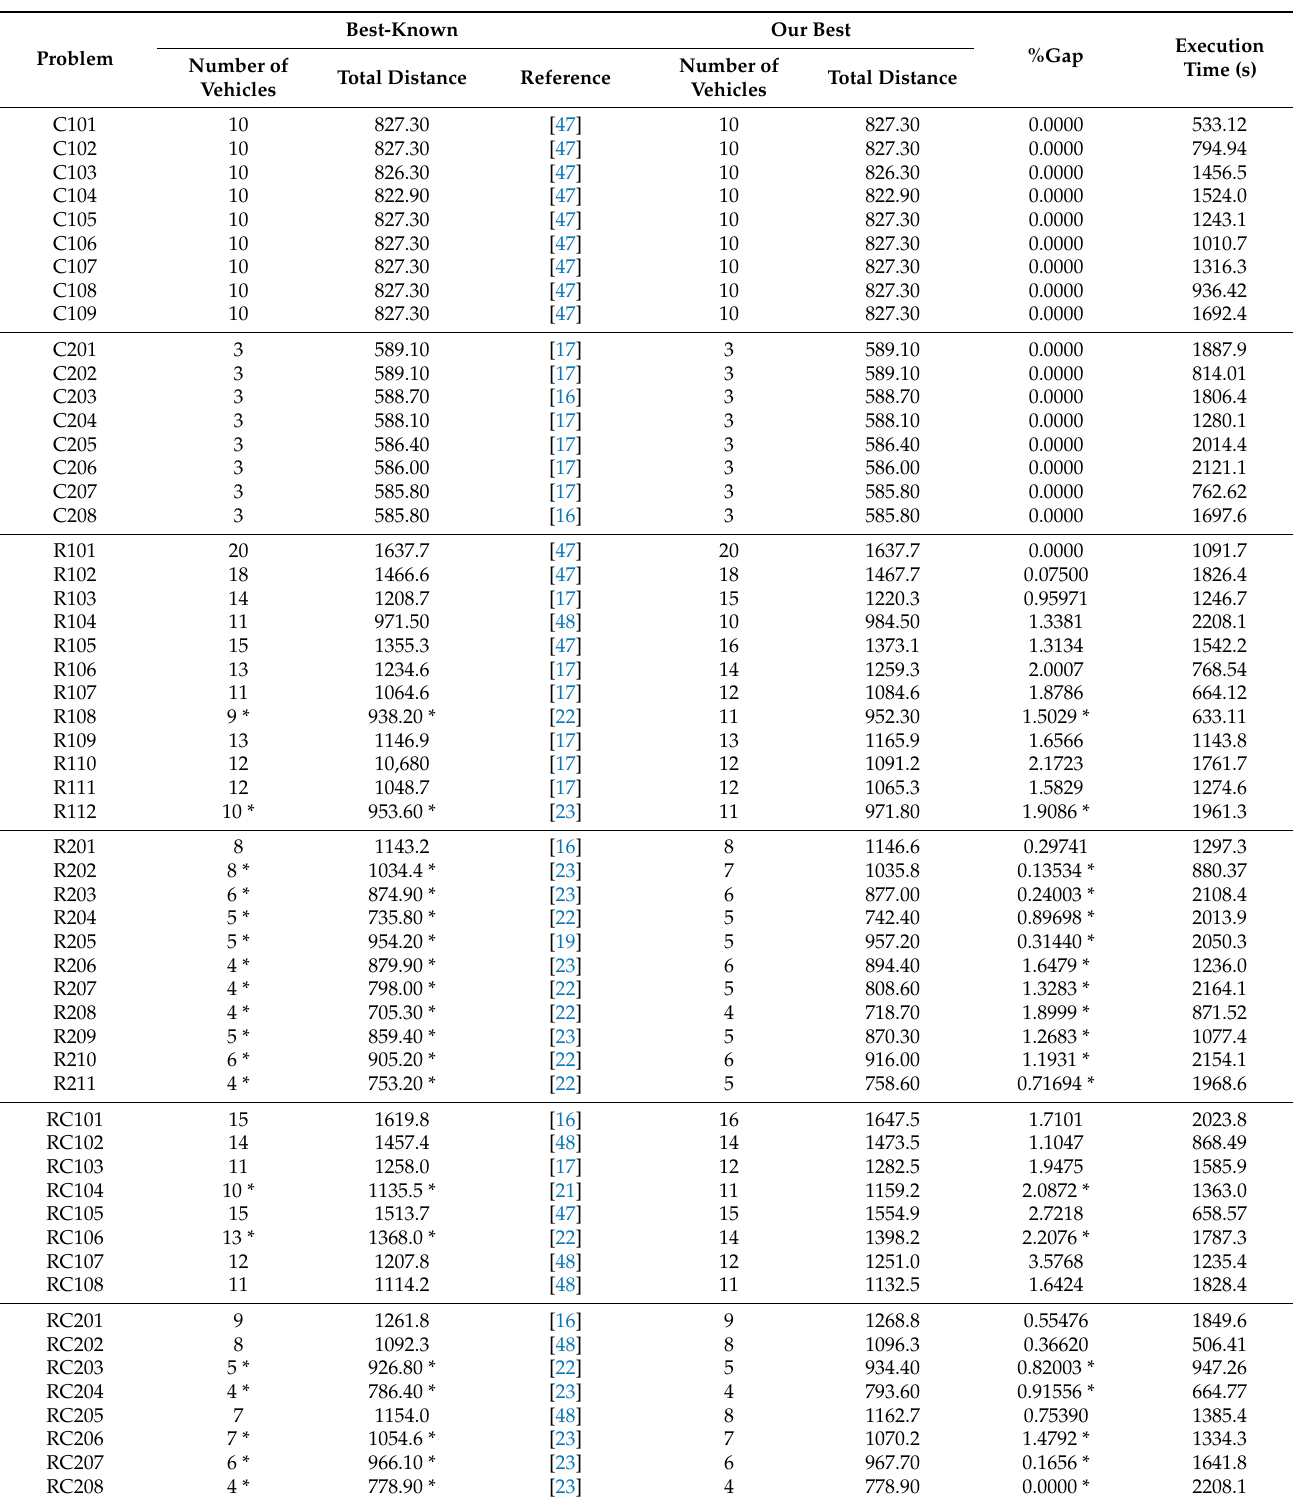
Table 5. Comparisons between the exact solution or best solutions (with “*”) and the results obtained by our heuristic on 100-customer Solomon